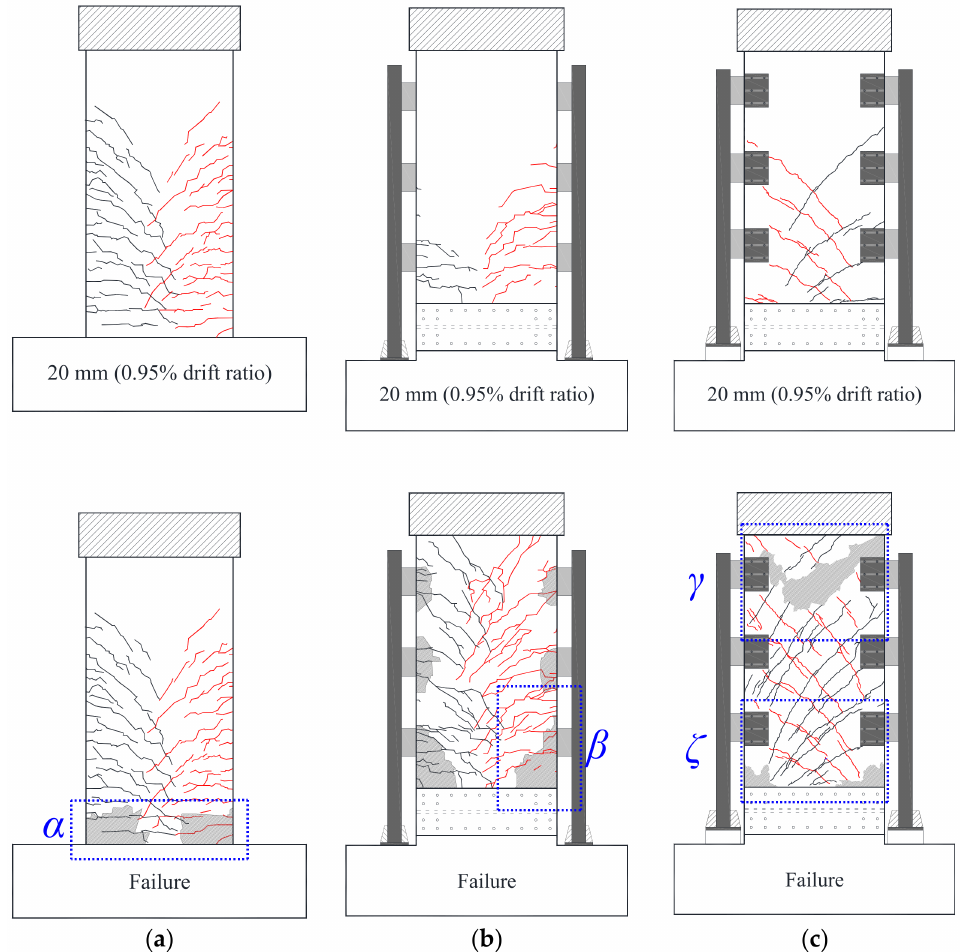
Figure 14. Crack distribution of testing walls (black and red lines represent the cracks as subjecting to different loading direction). ( a ) W0; ( b ) W1-R; ( c ) W2-R.